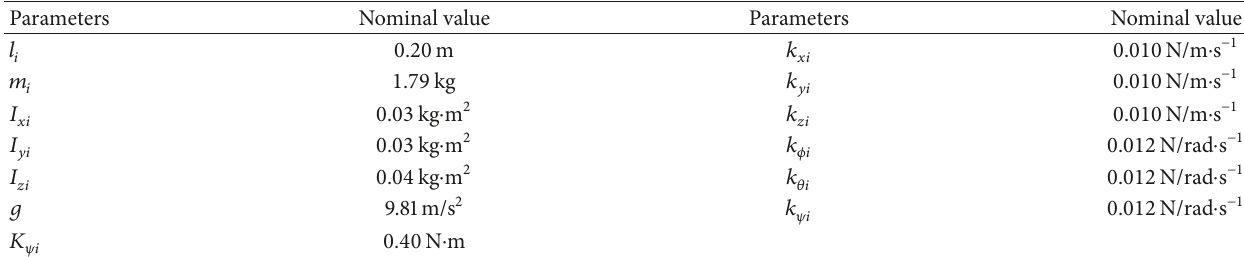
Table 1: The system parameters of quadrotor UAVs.